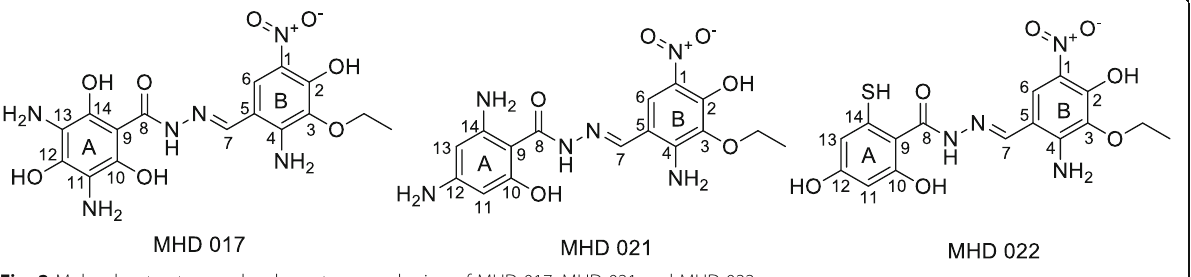
Fig. 2 Molecular structure and carbon atom numbering of MHD 017, MHD 021 and MHD